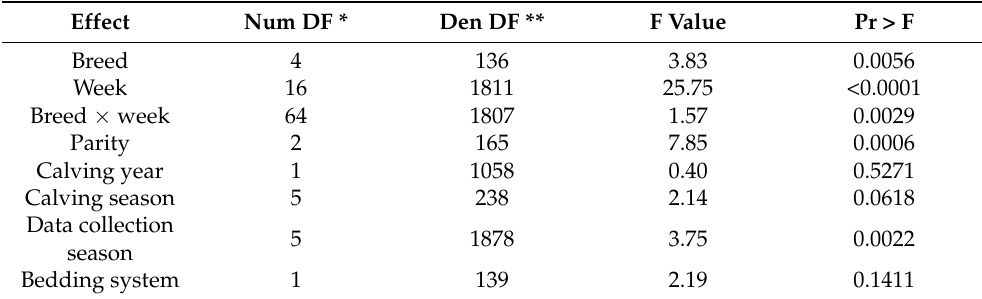
Table A4. Variance analysis results for the variable non-esterified fatty acids (NEFA).